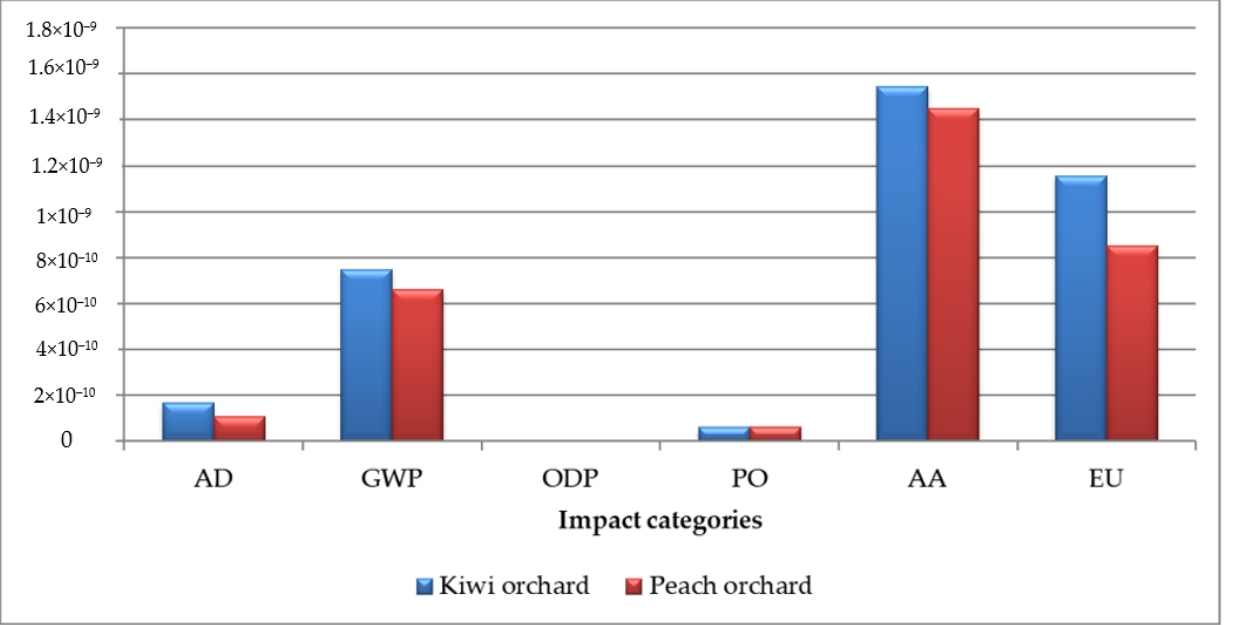
depletion; GWP: Global warming potential; ODP: Ozone layer depletion; PO: Photochemical oxida-